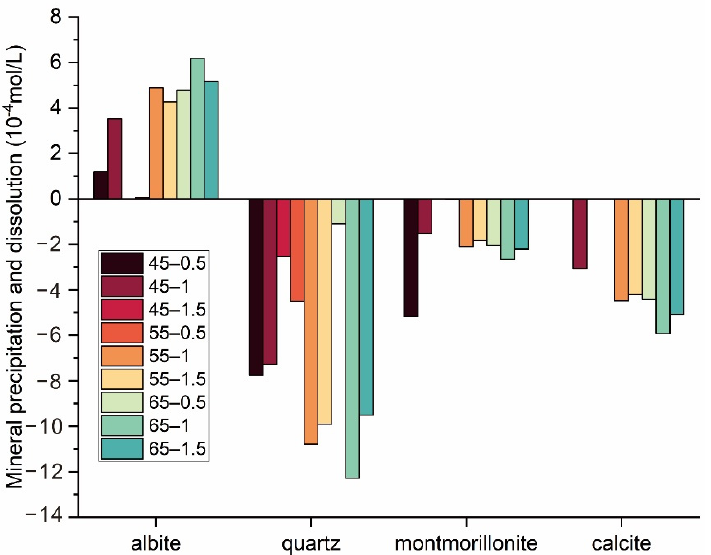
Figure 6. Mineral precipitation and dissolution under different temperature and flow conditions. Positive numbers indicate mineral dissolution; negative numbers indicate precipitation.